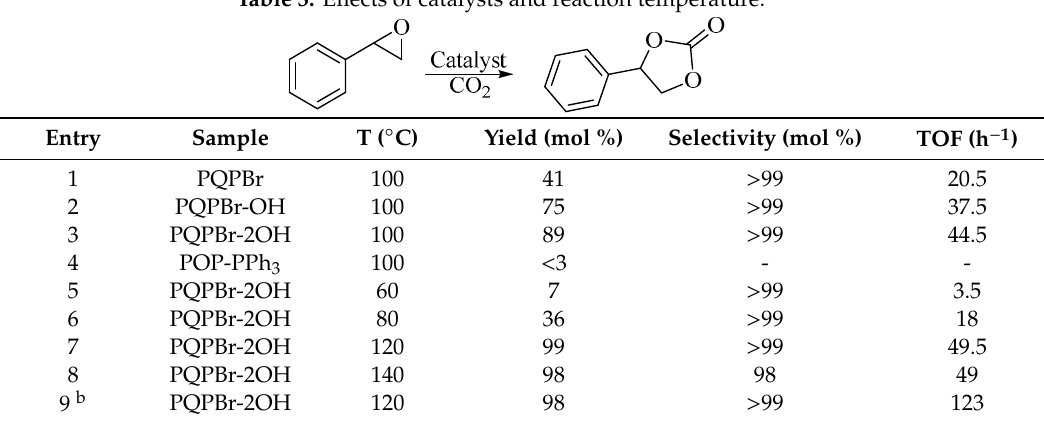
Table 3. Effects of catalysts and reaction temperature. a Table 3. E ff ects of catalysts and reaction temperature. a